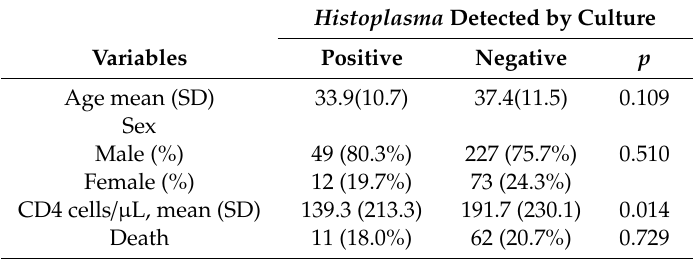
Table 1. Variables evaluated in the bu ff y coat culture for the diagnosis of disseminated histoplasmosis in AIDS-patient in an endemic area of South America. Fortaleza, Cear á , Brazil,